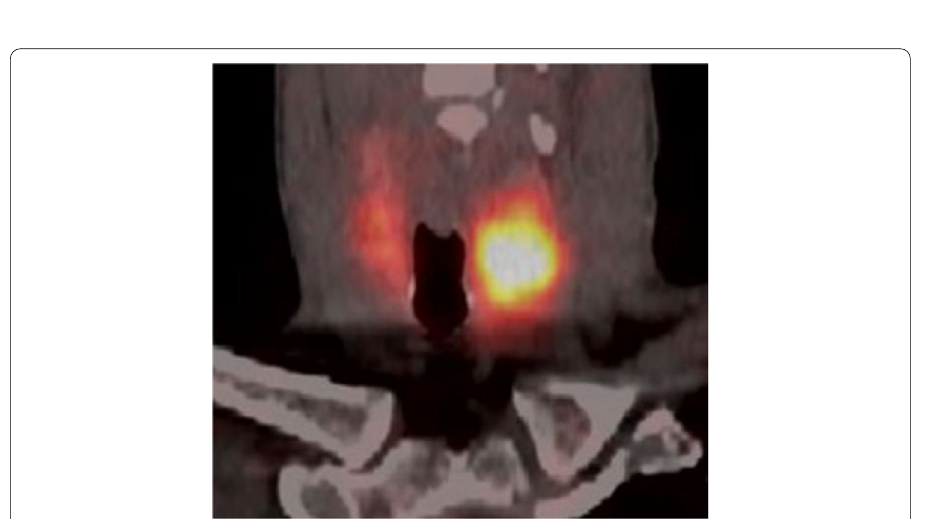
Fig. 2. 68 Ga-DOTATATE PET/CT coronal fusion image showing high uptake in the left thyroid nodule and mild and diffuse physiological uptake in the right